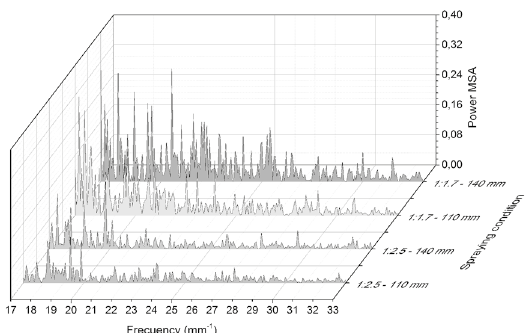
Figure 10. Power Spectral Density (PSD) of AT-13 coatings surfaces